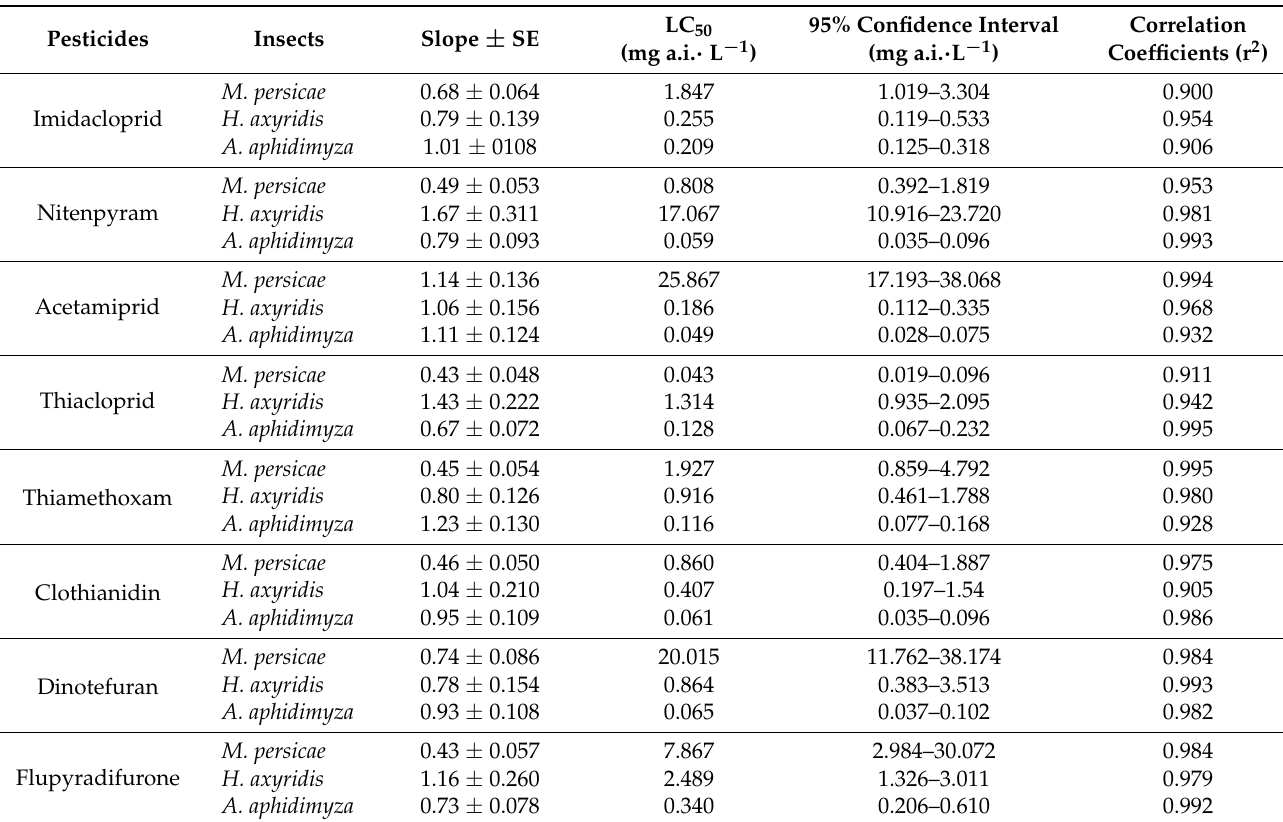
Table 1. Acute toxicity data of eight neonicotinoid pesticides tested on the aphids and the natural enemies. Pesticides